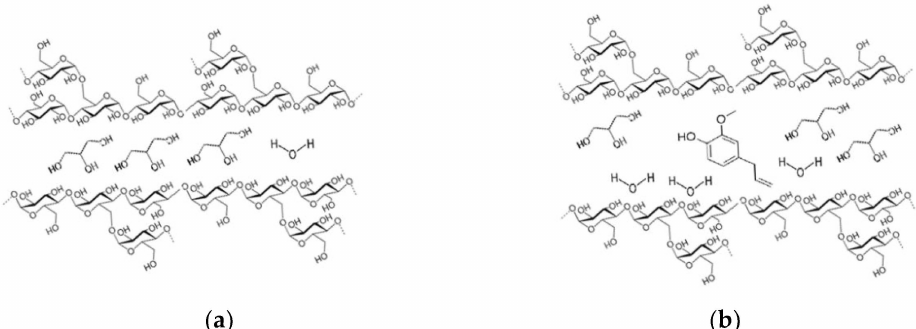
Figure 3. Representation of ( a ) molecules of starch plasticized with glycerol and water, and ( b ) molecules of starch, among which there are components of EOs that increase the intermolecular space and allow greater passage of water molecules, plasticizing the polymeric matrix.